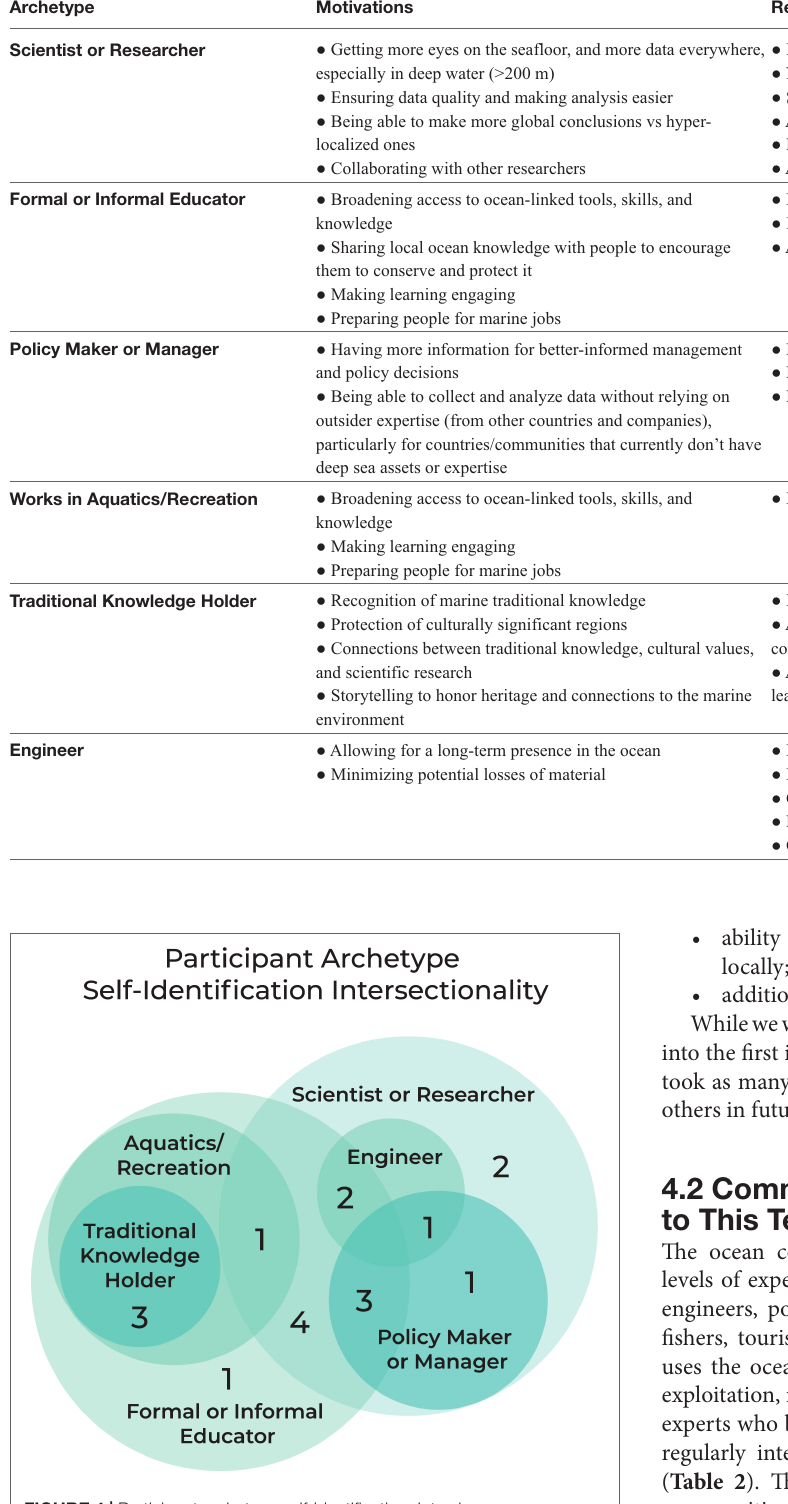
FIGURE 4 | Participant archetype self-identification. Interviewees were asked to identify up to three out of six domains/communities which they represented the most. Eighteen out of twenty interviewees